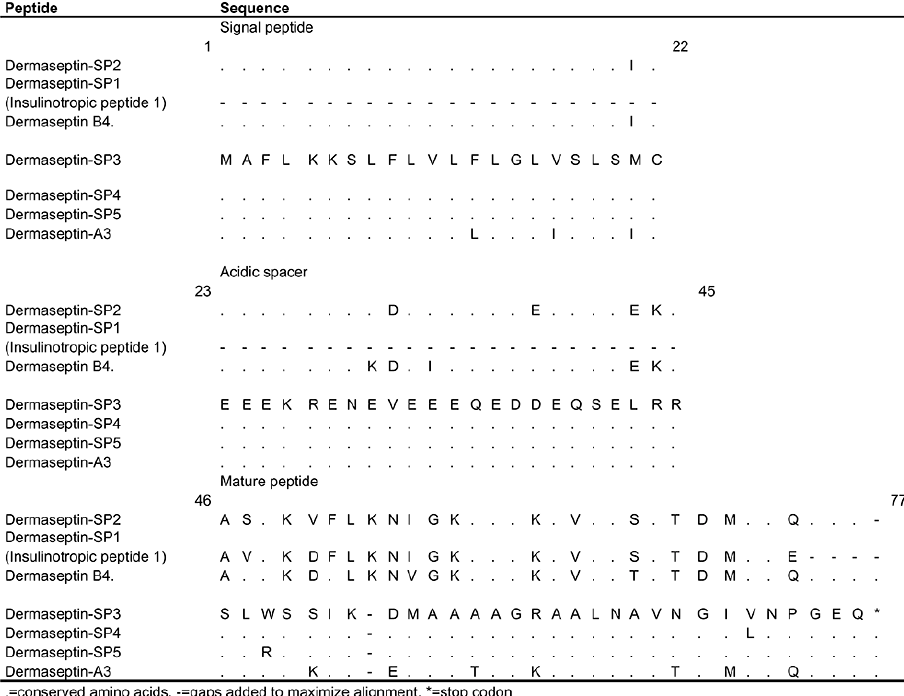
Figure 4. Comparison of amino acid sequence similarity of dermaseptins. DRS-SP1–DRS-SP4, and insulinotropic peptide 1 of A. spurrelli , DRS-A3 of A. annae , and DRS-B4 of P. bicolor (accession